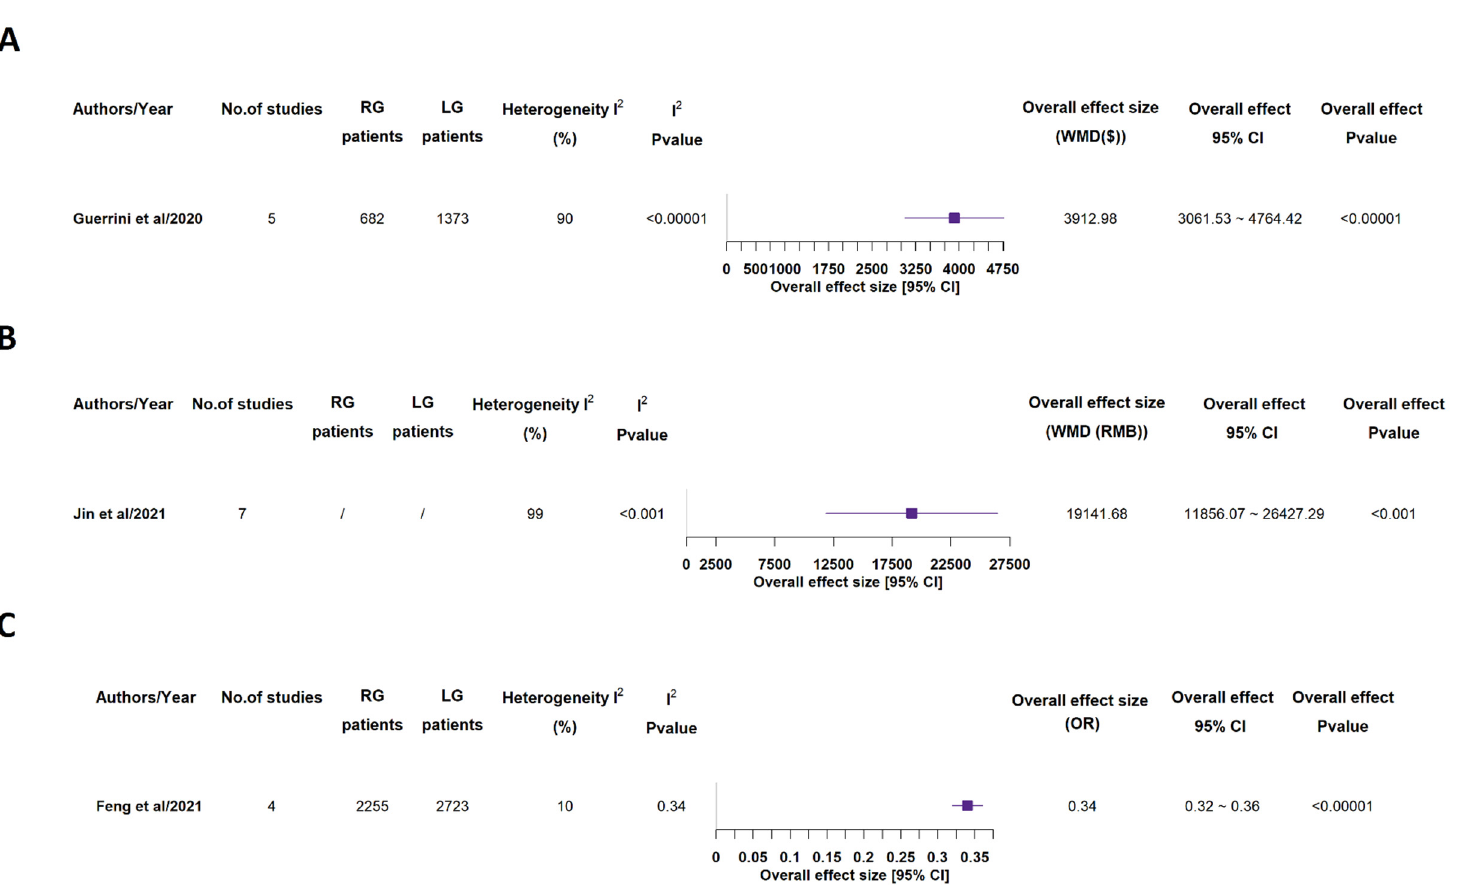
Figure 11. Costs. RG = Robotic gastrectomy; LG = Laparoscopic gastrectomy; WMD = weighted mean difference; $ = US dollars ( A ); RMB = People’s Republic of China renminbi ( B ); OR = odds ratio ( C ) [15,16,19].